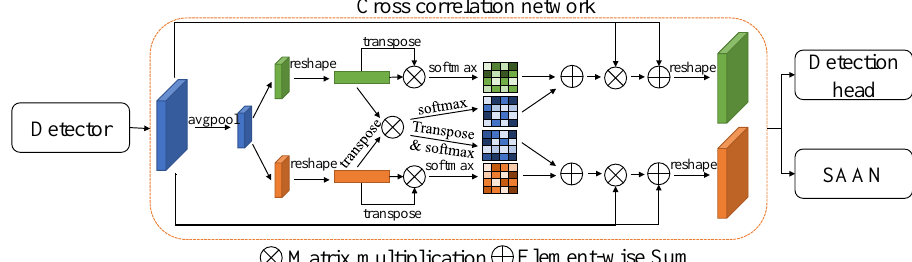
Figure 12. Example of a model using appearance variations, drifting, and identity switching